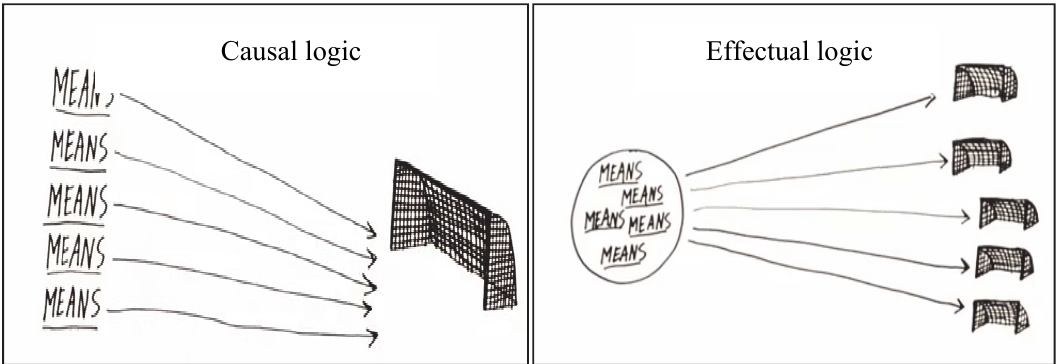
Fig. 1. Causal logic Vs effectual